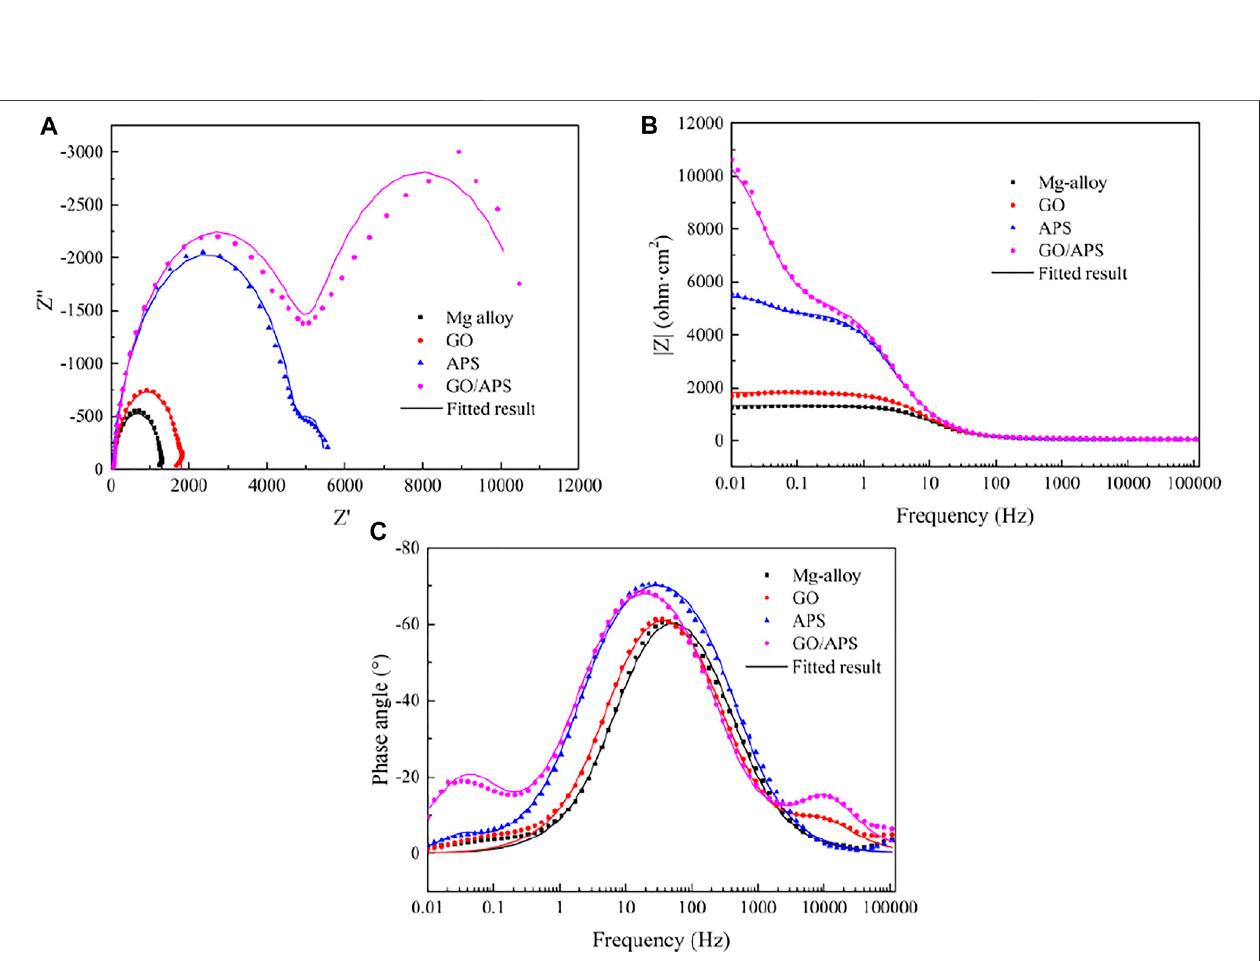
Frontiers in Materials |